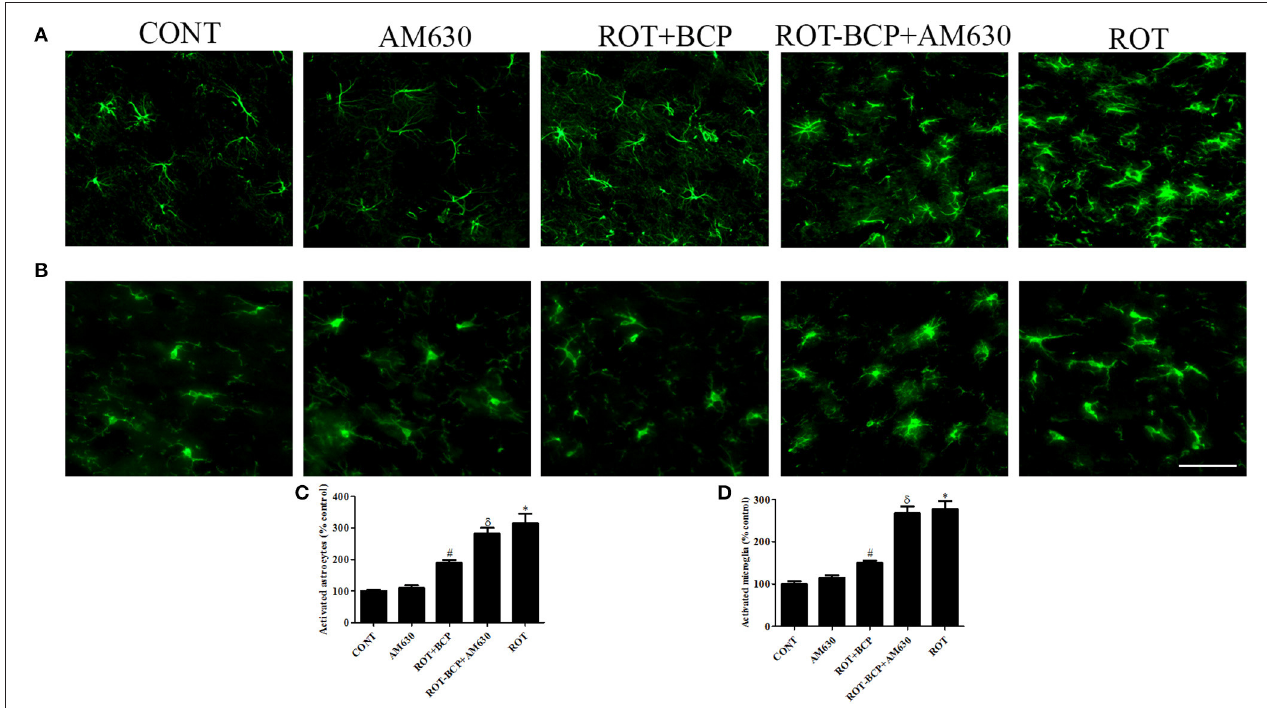
FIGURE 5 | The immunofluorescence staining to detect the expression of glial fibrillary acidic protein (GFAP) positive astrocyte and ionized calcium binding adaptor molecule-1 (Iba-1) positive microglia in the striatum. Values are expressed as percent mean ± SEM ( n = 3). The scale bar is 200 µ m. Profound expression of GFAP positive astrocytes (A) and Iba-1 positive microglia (B) was found in the ROT-administered and ROT-BCP + AM630 groups as compared to the vehicle-injected CONT and AM630-only groups. While BCP supplementation to ROT-injected rats showed moderate staining of GFAP and Iba-1 as compared to ROT-injected rats. Quantitative analysis of activated astrocytes (C) and microglia (D) has shown that significant (* p < 0.05) increase in number of activated astrocytes and microglia was observed in the ROT group as compared to the CONT group. However, BCP supplementation significantly (# p < 0.05) reduced the number of activated astrocytes and microglia in the ROT + BCP group as compared to the ROT group. The ROT-BCP + AM630 group also showed significantly ( δ p < 0.05) increased number of activated astrocytes and microglia when compared to the ROT + BCP group. The CONT and AM630-only groups did not show any marked difference in the activation of astrocytes and